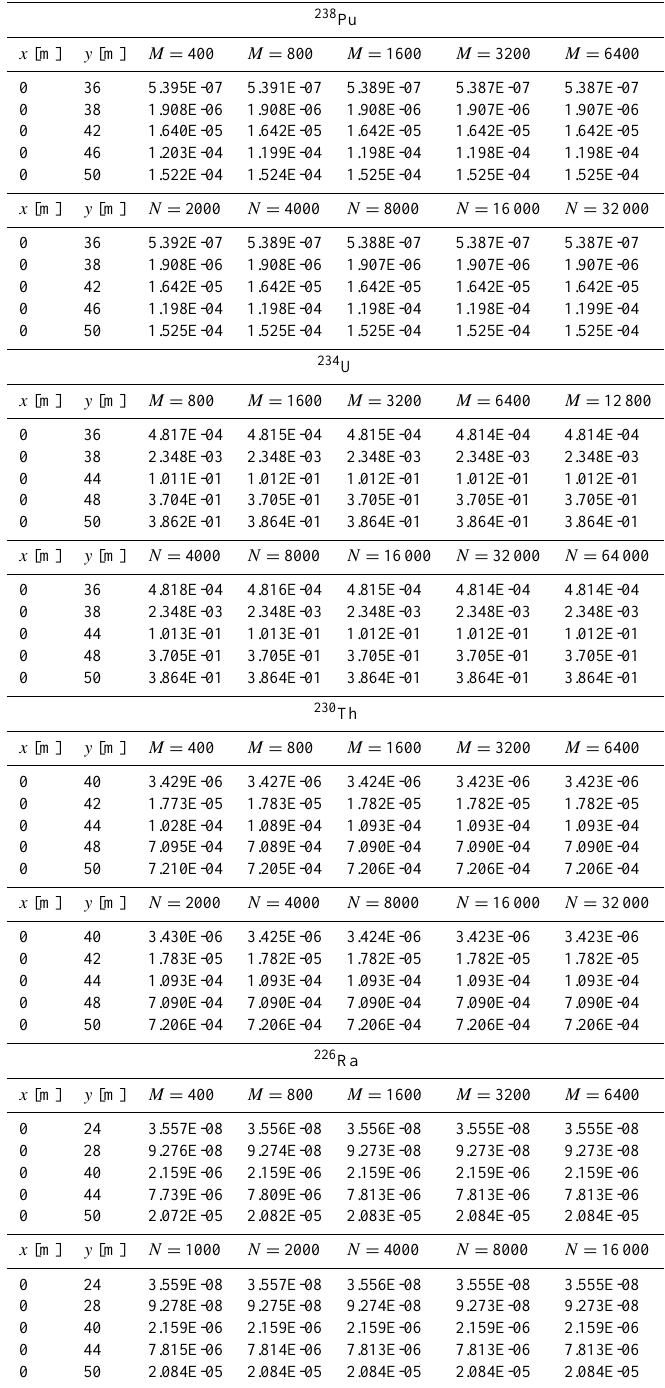
Table 6. Solution convergence of each species concentration at transect of inlet boundary ( x = 0 m) for four-species radionuclide trans- port problem considering simulated domain of L = 2500m, W = 100m subject to Bateman-type sources located at 45m ≤ y ≤ 55m for t = 1000years ( M = number of terms summed for inverse generalized integral transform; N = number of terms summed for inverse fi- nite Fourier cosine transform). When we investigate the required M for inverse generalized integral transform, N = 12800 for the finite Fourier cosine transform inverse are used. When we investigate the required N for inverse finite Fourier cosine transform, M = 6400 for the generalized transform inverse are